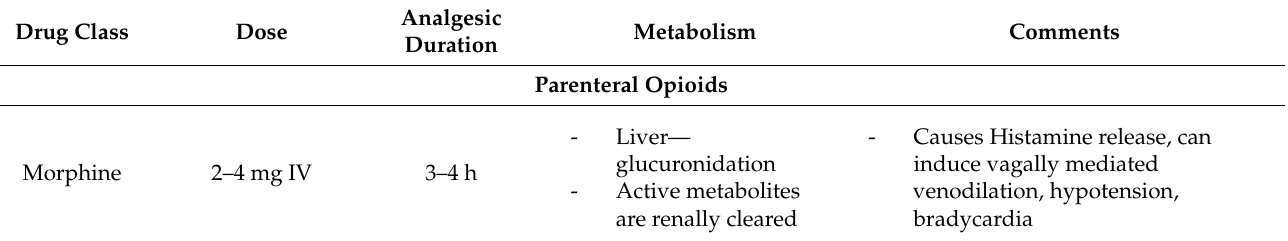
Table 1. Opioids